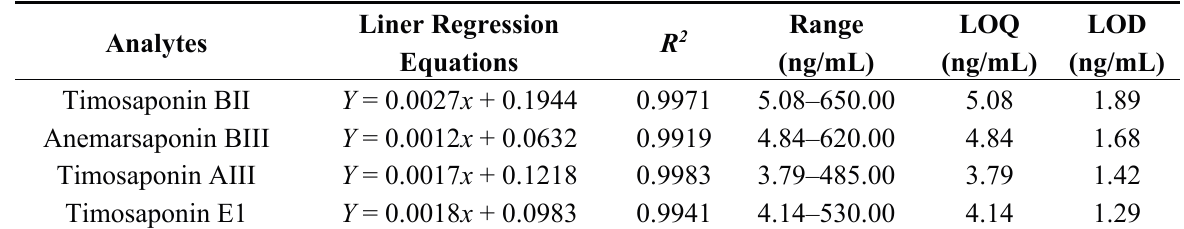
Table 1. The regression equations, liner range, LLOQs and LODs of the four compounds. Liner Regression Analytes